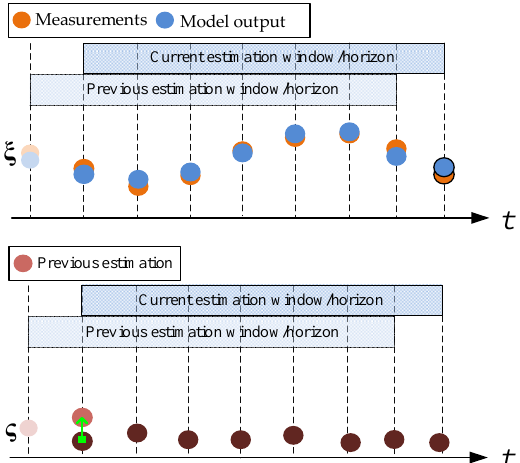
Figure 3. MHE schematic diagram.